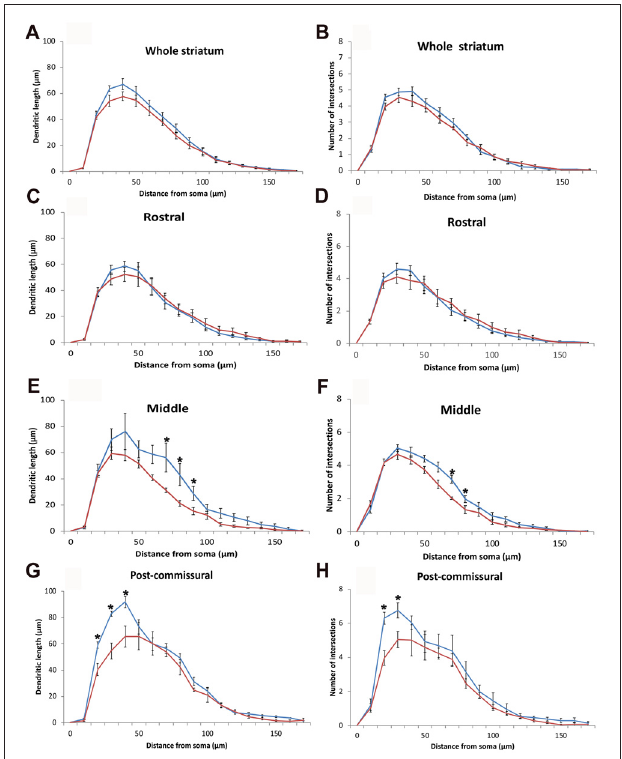
FIGURE 6 | (A–H) Quantitative morphometric data (Mean ± SEM) from Sholl analysis about the length (A,C,E,G) and extent of arborization (B,D,F,H) of the dendritic tree of striatal ChIS according to incremental radii of 10 µ m from the center of their perikaryon in WT (blue traces, N = 6, 20 cells/animal) and DRD (red traces, N = 6, 20 cells/animal) mice. Mean dendritic length and number of intersections made by the dendritic tree of ChAT-positive neurons were not significantly different in DRD mice compared to WT throughout all the concentric circles for the whole striatum (A,B) , but reached statistical significance in specific circles away from the soma in the middle (E,F) and post-commissural (G,H) tiers of the striatum ( ∗ p < 0.05).